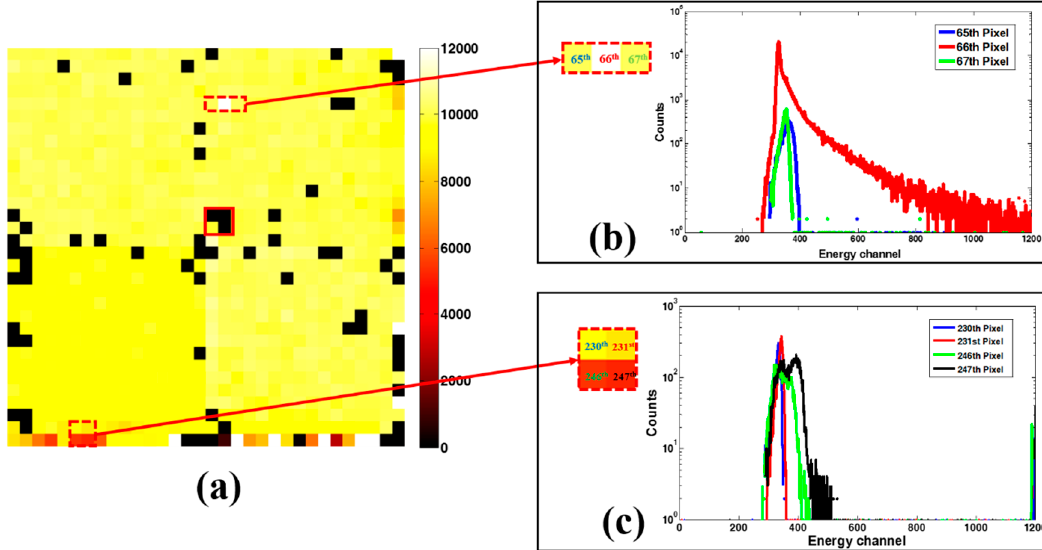
Figure 6. Spectra and counts are measured by flood phantom from a 2 × 2 modules of detector. ( a ) The Tc-99m flood image, the black spot (no counts) in the detector area (solid box) is caused by a cluster defect region. The white and brown spots (dashed box) in the image can be attributed to irregular response pixels; ( b ) Extreme high response pixels compared with adjacent normal pixels; ( c ) Pixels which show split or broadening spectral peak at the edge of detector.